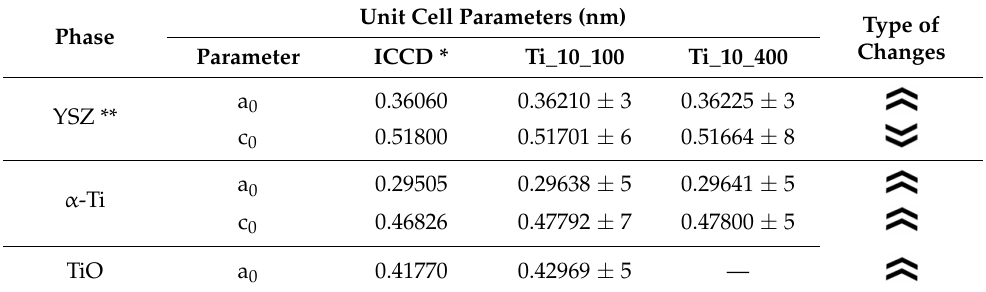
Figure 5. XRD patterns of embedded coatings. Table 4. Summary of changes in individual phases of the lattice parameter of deposited